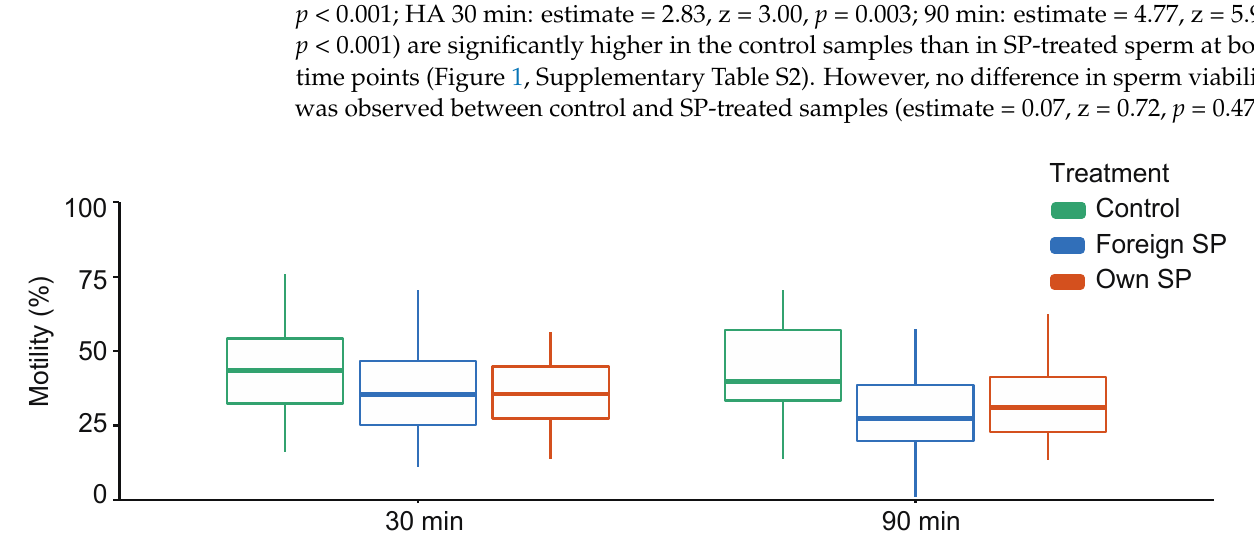
Figure 1. Sperm swimming velocity in different sperm treatments (control, foreign seminal plasma, and own seminal plasma) at both time points (30 min and 90 min). Bolded horizontal lines in each box plot denote median values and boxes extend from the 25th to the 75th percentile of the distribution of values. Vertical lines show the minimum and maximum values of the data. SP = seminal plasma.